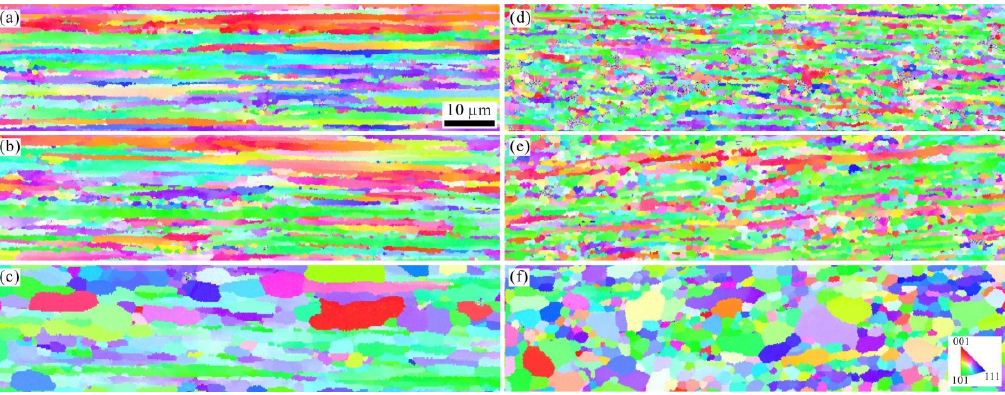
Figure 7. The axial orientation distribution maps of (a) the cold-drawn CPAW, (b) the CPAW annealed at 90 °C for 8 h, (c) the CPAW annealed at 250 °C for 8 h, (d) the cold-drawn AFW, (e) the AFW annealed at 200 °C for 8 h, (f) the AFW annealed at 250 °C for 8 h. The grain width and the grain length of the CPAWs and the AFWs were measured on the basis of the radial TEM images and the axial orientation distribution maps, respectively. In this paper, all grain boundaries with the misorientation angle of more than 2° were used for statistics.